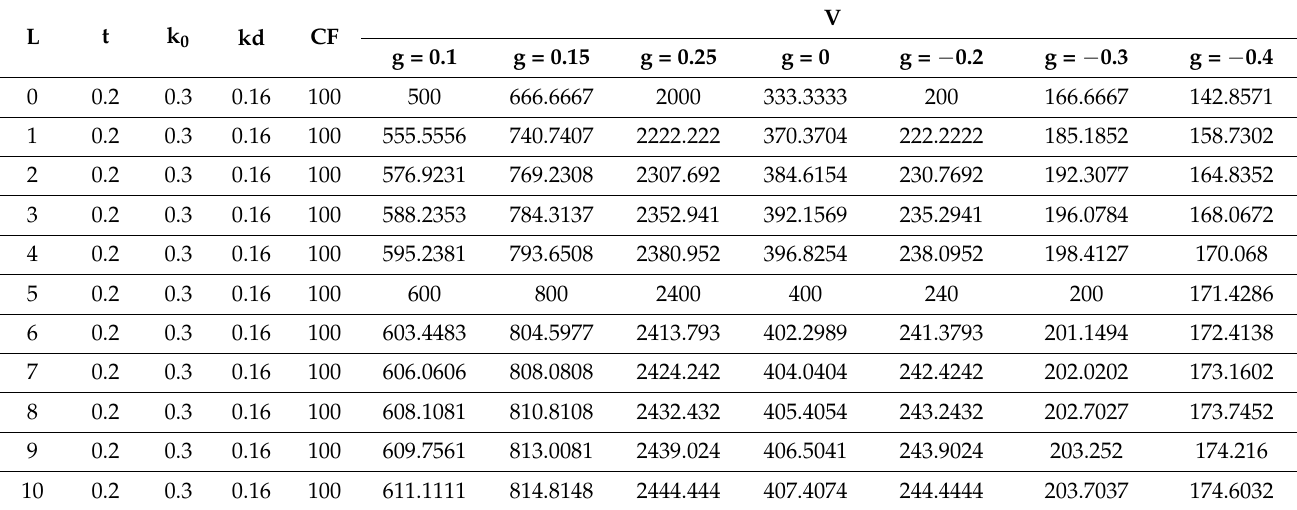
Table 6. Dependence of company value V on leverage level L in Generalized Modigliani–Miller theory (GMM theory) at g = 0.25. k 0 = 0.3 and